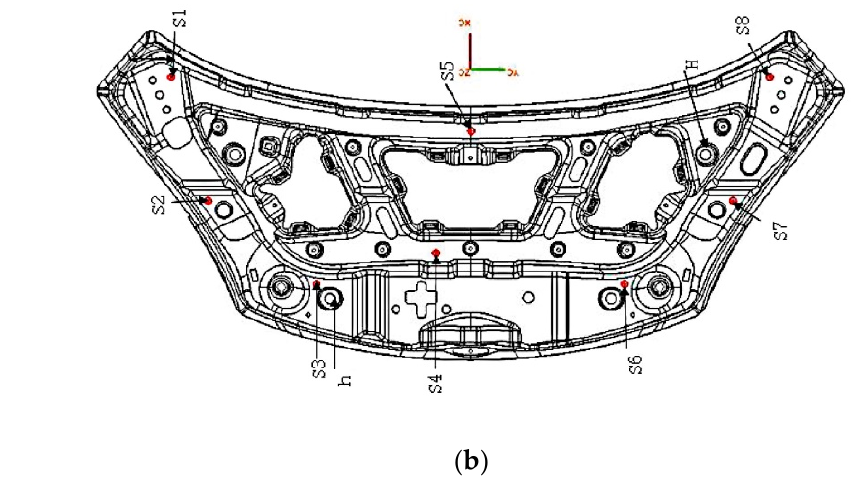
Figure 5. Measurement device and reference of spring back. ( a ) Three-coordinates measuring machine; ( b ) Measurement reference.